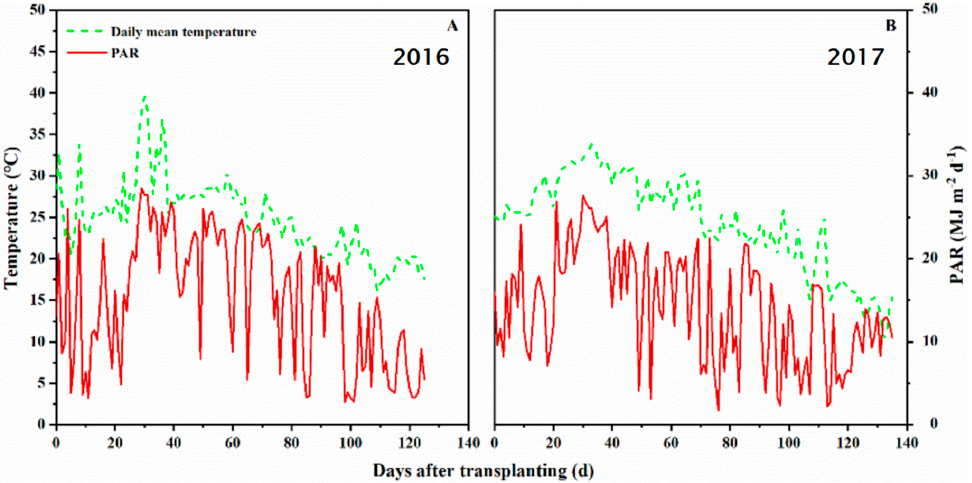
Figure 1. Daily mean temperature and photosynthetic active radiation (PAR) during rice growth season at Rugao County, Jiangsu Province, China in 2016 ( A ) and 2017 ( B ).